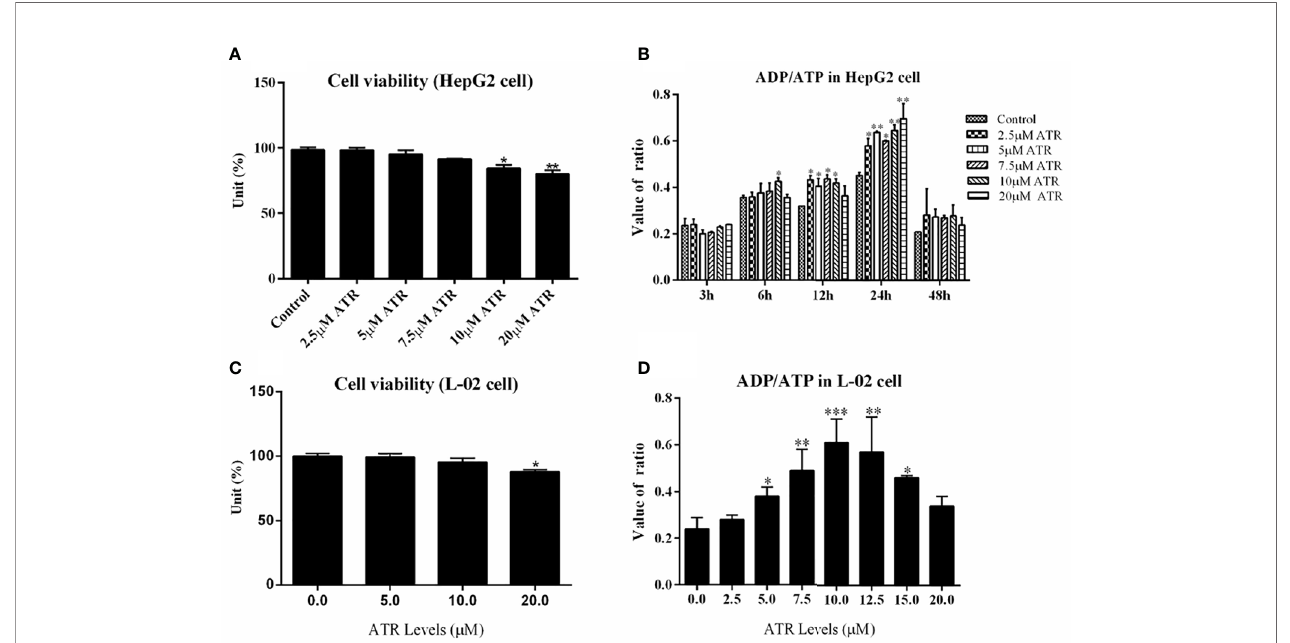
FIGURE 1 | Safe concentration of ATR and upregulation of ADP/ATP in hepatocytes (HepG2 and L-02 cells). (A) Cell viability of HepG2 cells exposed to ATR (CCK- 8 assay). (B) Value of ADP/ATP in ATR-treated HepG2 cells. (C) Cell viability of L-02 cells exposed to ATR (CCK-8 assay). (D) Value of ADP/ATP in ATR-treated L- 02 cells (cells were treated with ATR for 24 h). Data are expressed as mean ± SD (n=3). *P<0.05, **P<0.01, ***P<0.001 (*represents ATR groups compared with the control